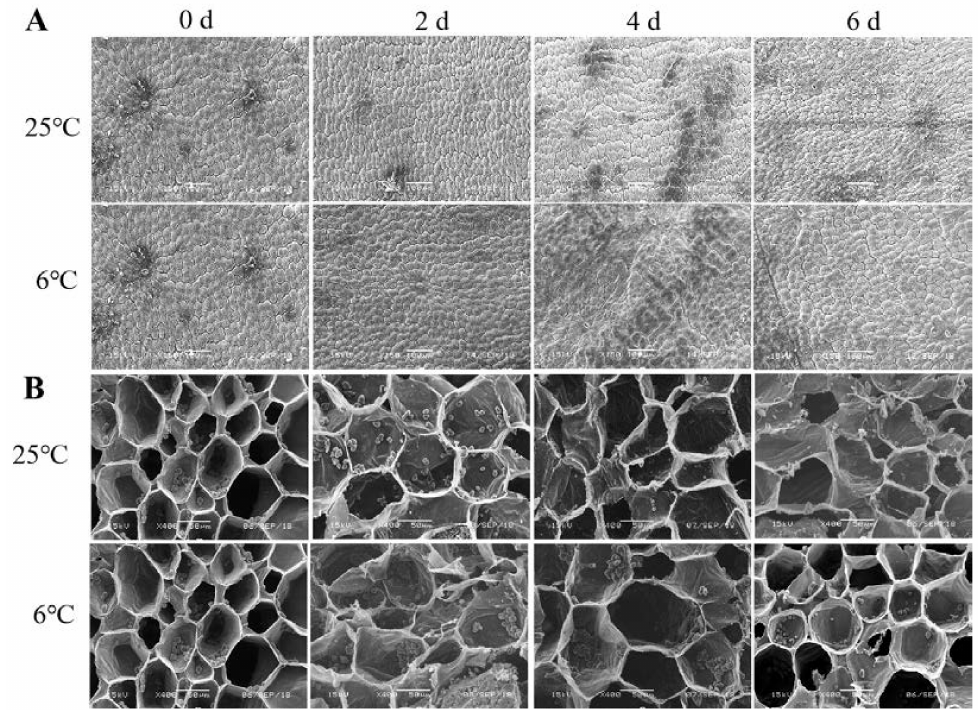
Figure 6. Structural changes of banana peel were observed by scanning electron microscope dur- ing storage at 6 ◦ C and 25 ◦ C. Epidermis structure ( A ) and Starch granules ( B ) of banana peel during